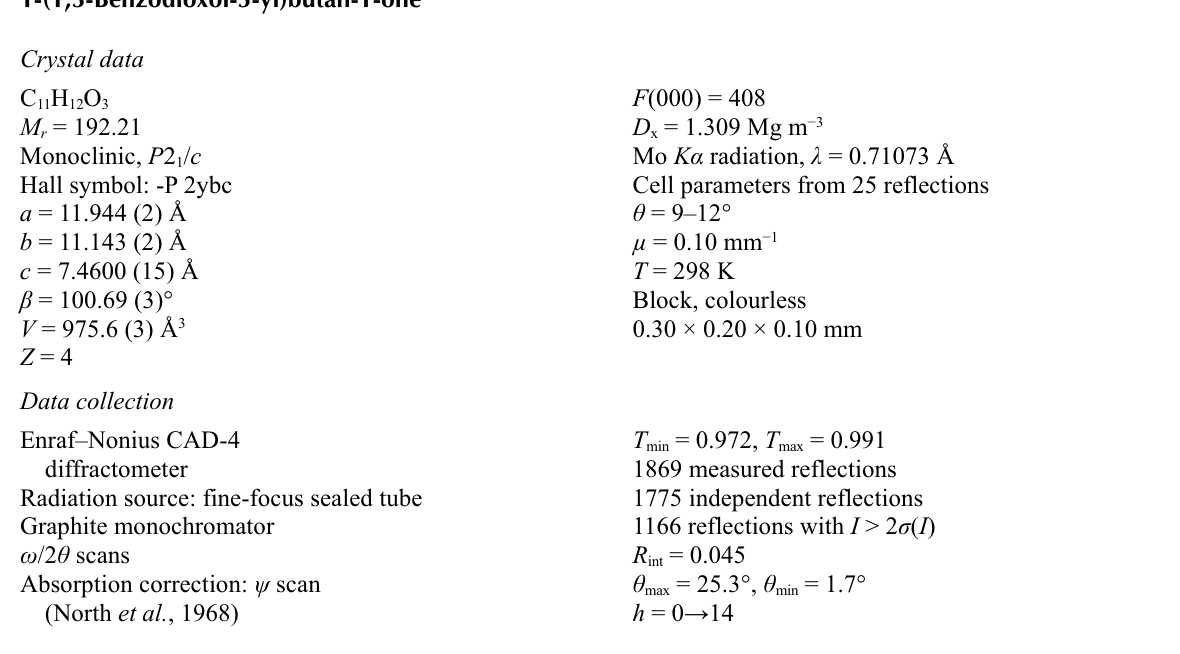
A partial packing diagram of the title compound. Hydrogen bonds are shown as dashed